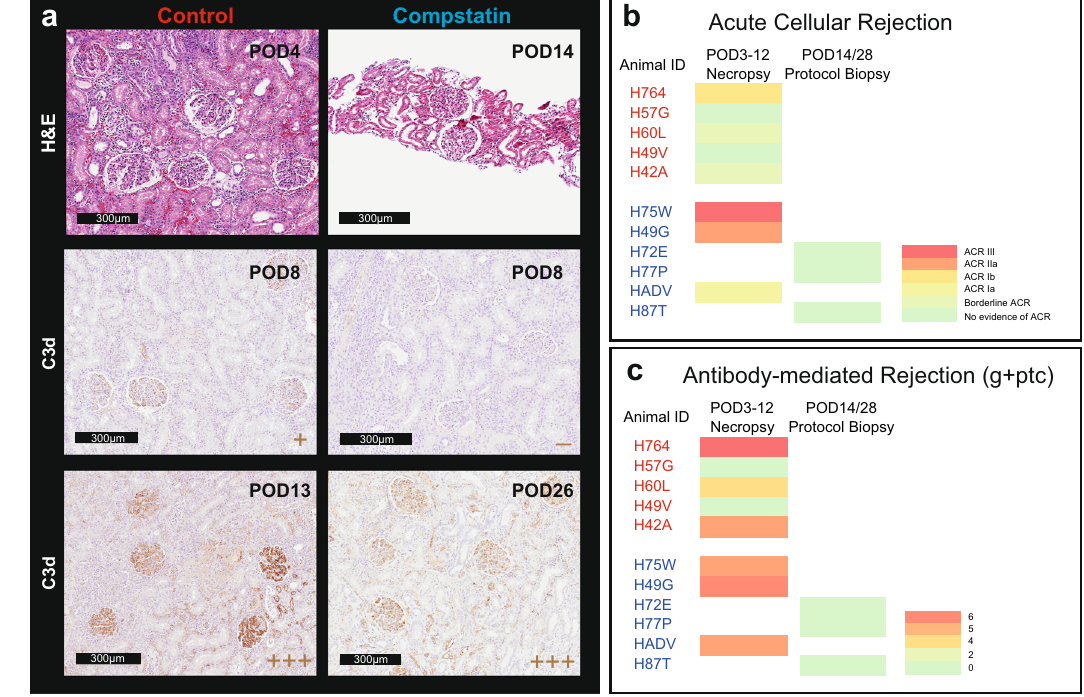
Fig. 3 Cp40 prevents antibody-mediated graft injury and intragraft C3d deposition. a Representative images of Hematoxylin and Eosin (H&E) and C3d immunohistochemistry staining of necropsy or biopsy specimens of the control ( n = 5) and Cp40 ( n = 6) groups. N number indicates biologically independent animals. b Heat map of acute cellular rejection scores of kidney allograft specimens of the control group (top/red) and Cp40 group (bottom/ blue). c Heat map of acute antibody-mediated rejection scores of kidney allograft specimens of the control group (top/red) and Cp40 group (bottom/ blue).